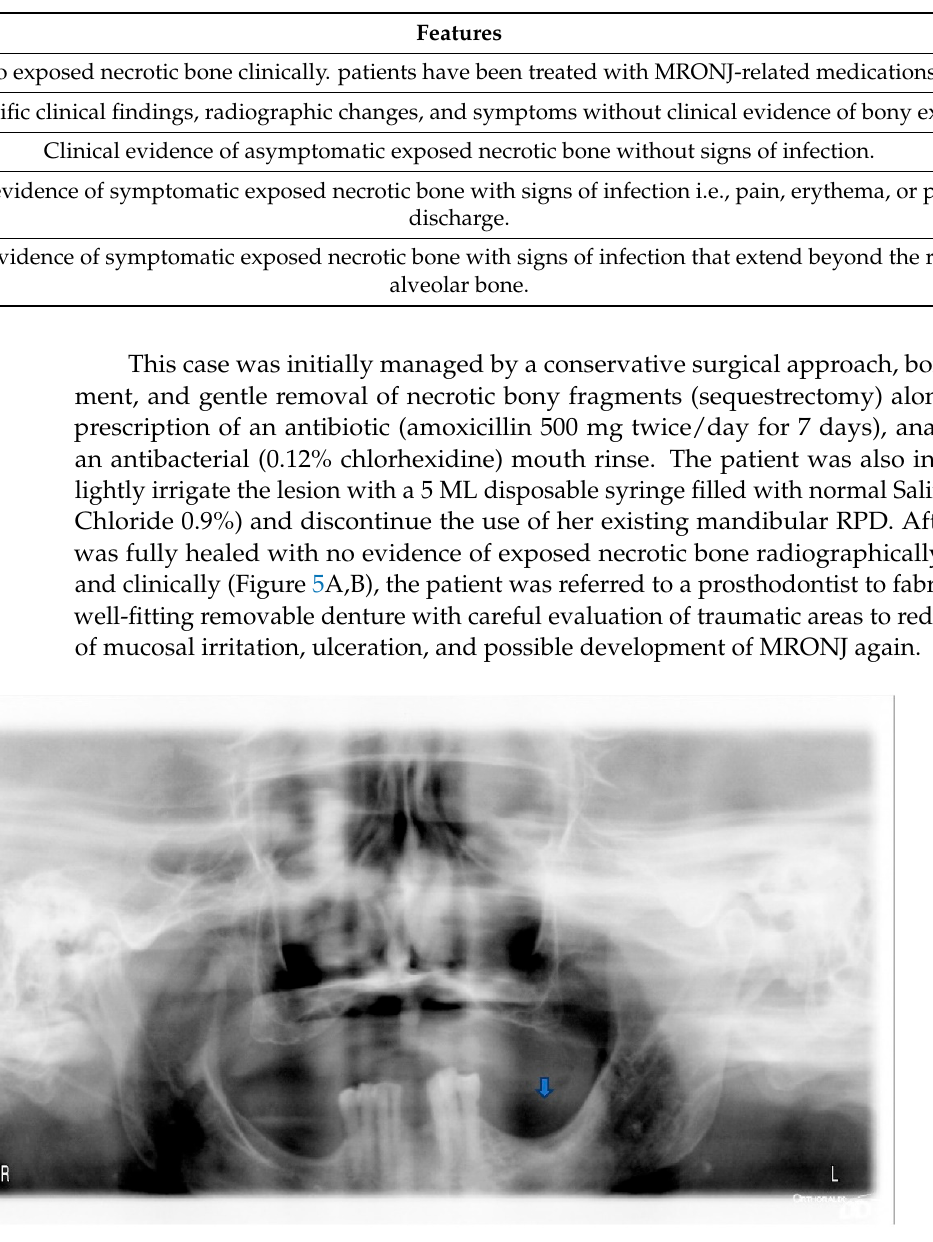
Figure 4. OPG radiograph showing complete healing with no evidence of necrotic bone on the left posterior alveolar ridge of the mandible as marked by blue arrow. R: right and L: left.